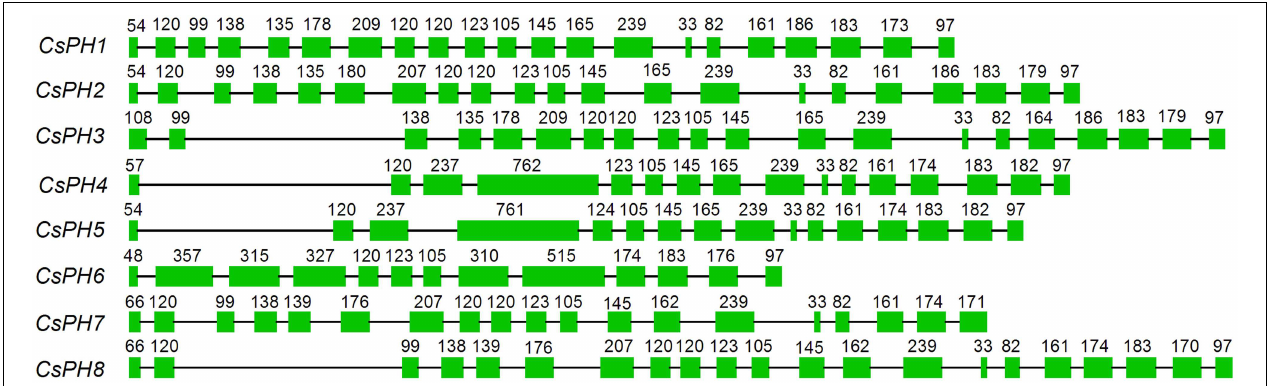
FIGURE 2 | Schematic gene structure of eight PH5 -like H + -ATPases in citrus. The boxes indicate the exon. The single line between the boxes indicates the intron. The numbers on the boxes indicate the exon length.